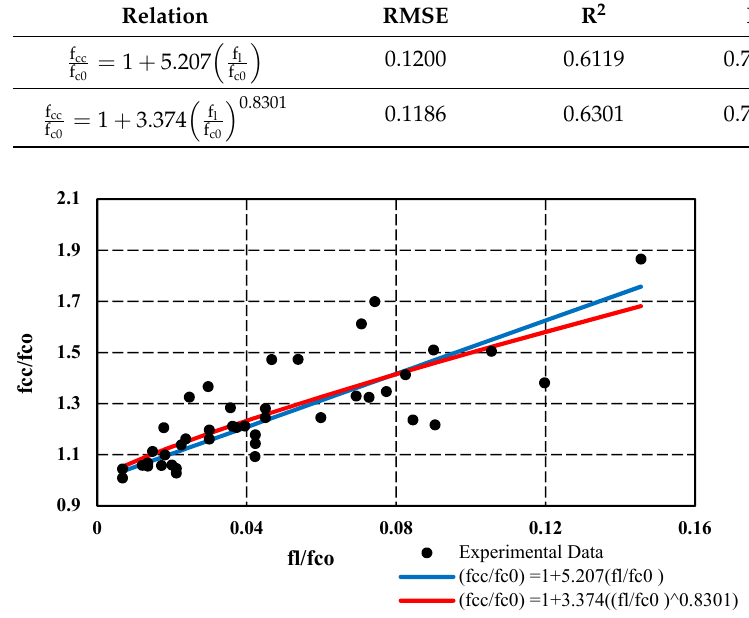
Figure 5. Regression analysis results of Equation (2) and Equation (3).